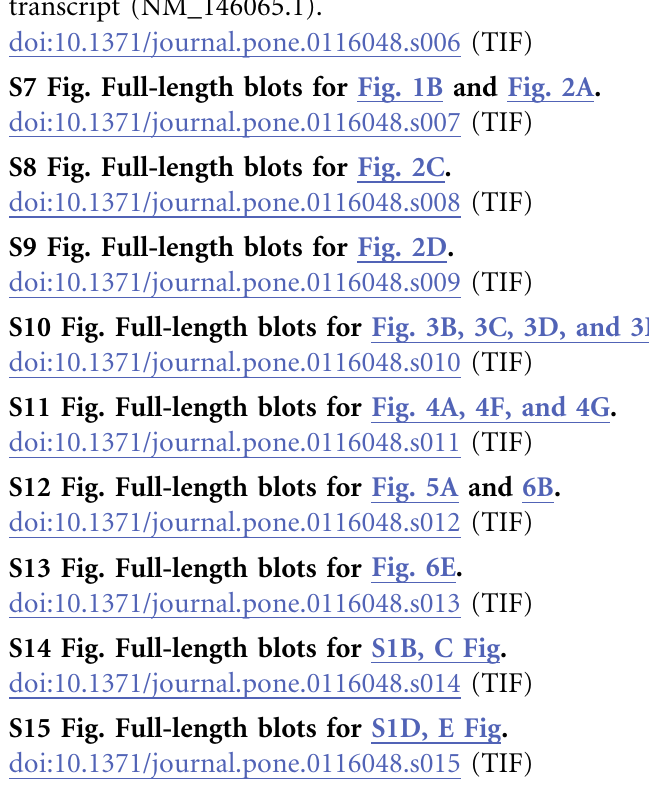
S6 Fig. Amino acid sequence alignment of ATF2 and ATF7. (A) The longest isoform of human ATF2 (isoform 1: NP_001243019.1) and the longest isoform of human ATF7 (isoform 2: NM_006856.2) are compared, and amino acid sequence identity (%) is shown. (B) Amino acid sequence alignment of mouse and human ATF7. The mouse ATF7 protein and the longest isoform of human ATF7 (isoform 2: NM_006856.2) are compared, because the mouse ATF7 gene generates a single transcript (NM_146065.1). S7 Fig. Full-length blots for Fig. 1B and Fig. 2A. S8 Fig. Full-length blots for Fig. 2C. S9 Fig. Full-length blots for Fig. 2D. S10 Fig. Full-length blots for Fig. 3B, 3C, 3D, and 3E. doi:10.1371/journal.pone.0116048.s010 (TIF) S11 Fig. Full-length blots for Fig. 4A, 4F, and 4G. S12 Fig. Full-length blots for Fig. 5A and 6B. S13 Fig. Full-length blots for Fig. 6E. S14 Fig. Full-length blots for S1B, C Fig. S15 Fig. Full-length blots for S1D, E Fig.